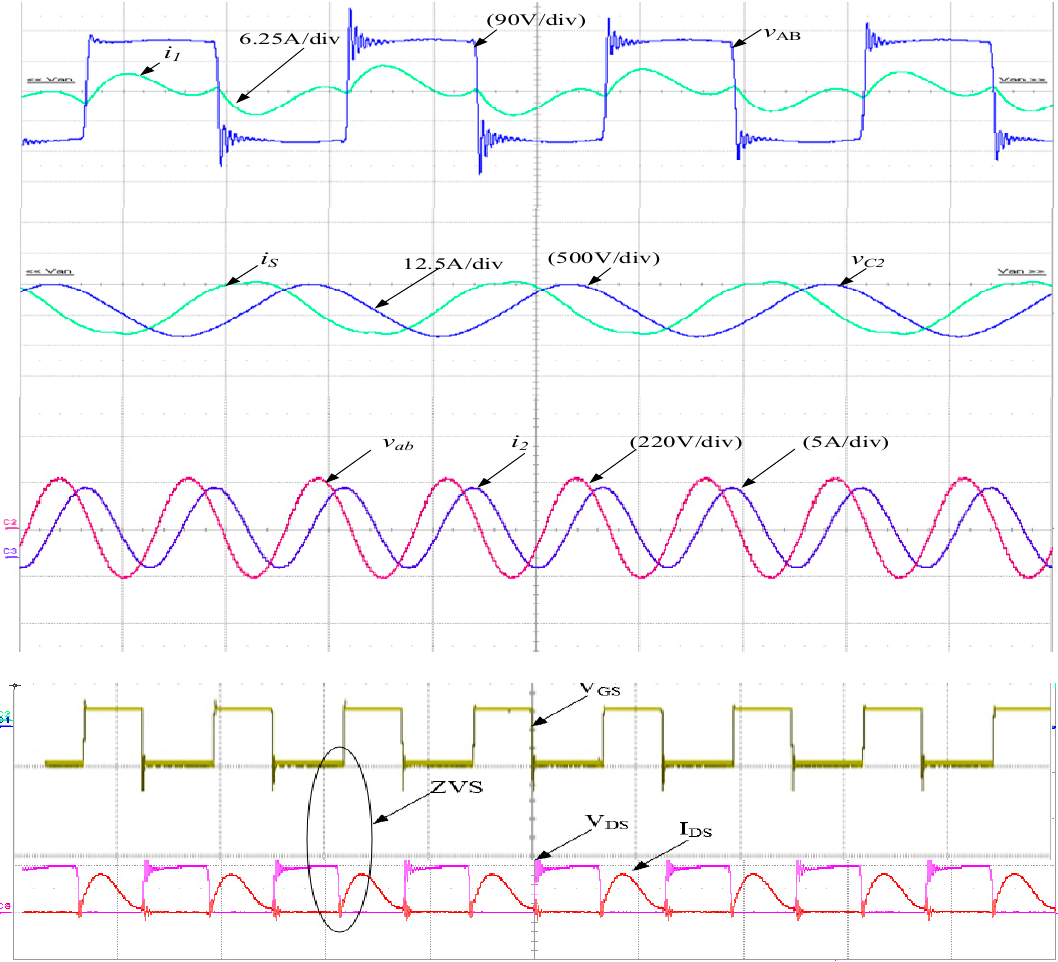
Figure 11. Laboratory results of the proposed LC-LC2 compensated resonant converter.